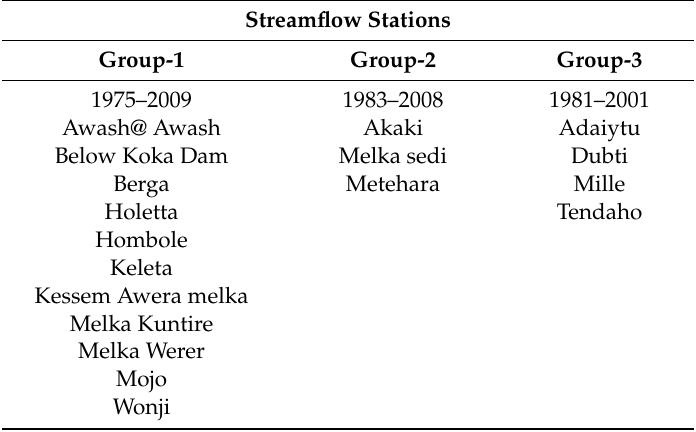
Table A2. Classification of Streamflow Stations in Awash River